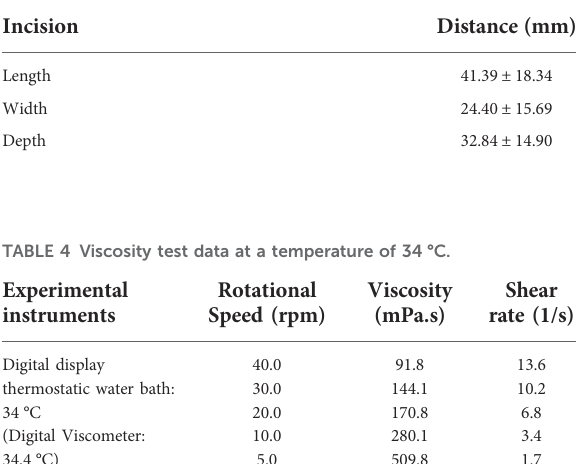
TABLE 3 Range of incision size after anal fi stula operation.